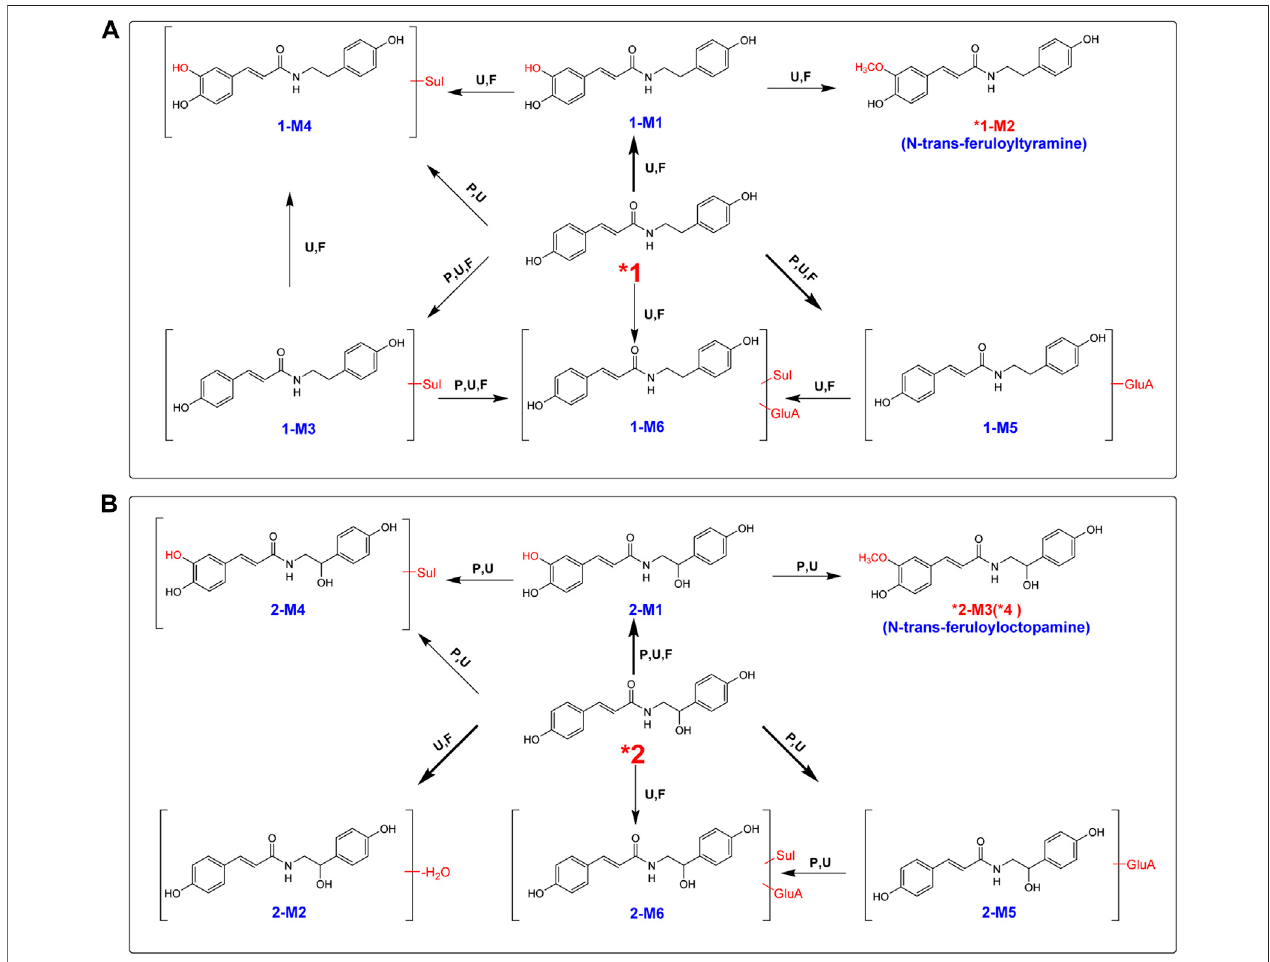
FIGURE4| Proposedmetabolicpathwayfor 1(A) and 2(B) inratsafteroraladministration.Boldredarrowsindicatemajormetabolites;*,comparedwithreference standards; U, detected in urine; p , detected in plasma; F, detected in feces; RLM, detected in rat liver microsomes; Sul, sulfate; GluA, glucuronic acid residue.